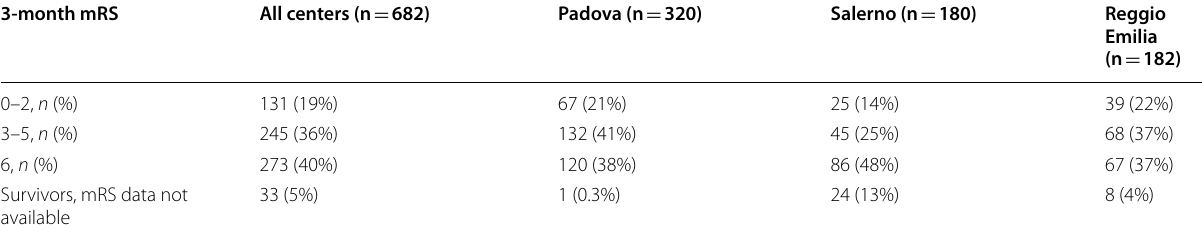
Table 2 Mortality and disability at 90 days from the index event